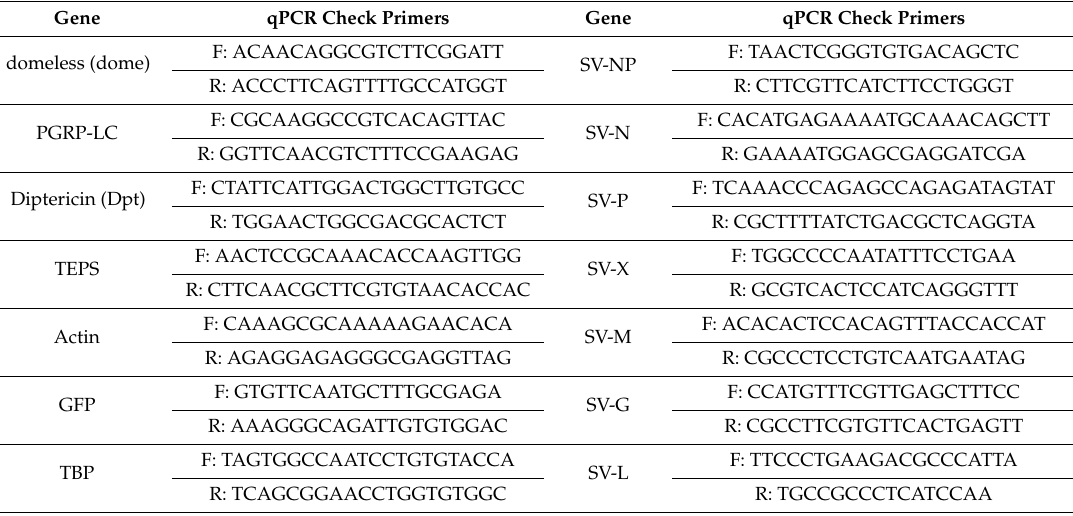
Table 2. The relative fold changes of gene expression were calculated through the ∆∆ Ct method [28]. Table 2. Primer sequences used in this